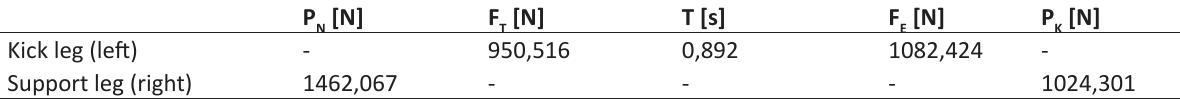
Table 2. Selected kinetic parameters for left leg front kick